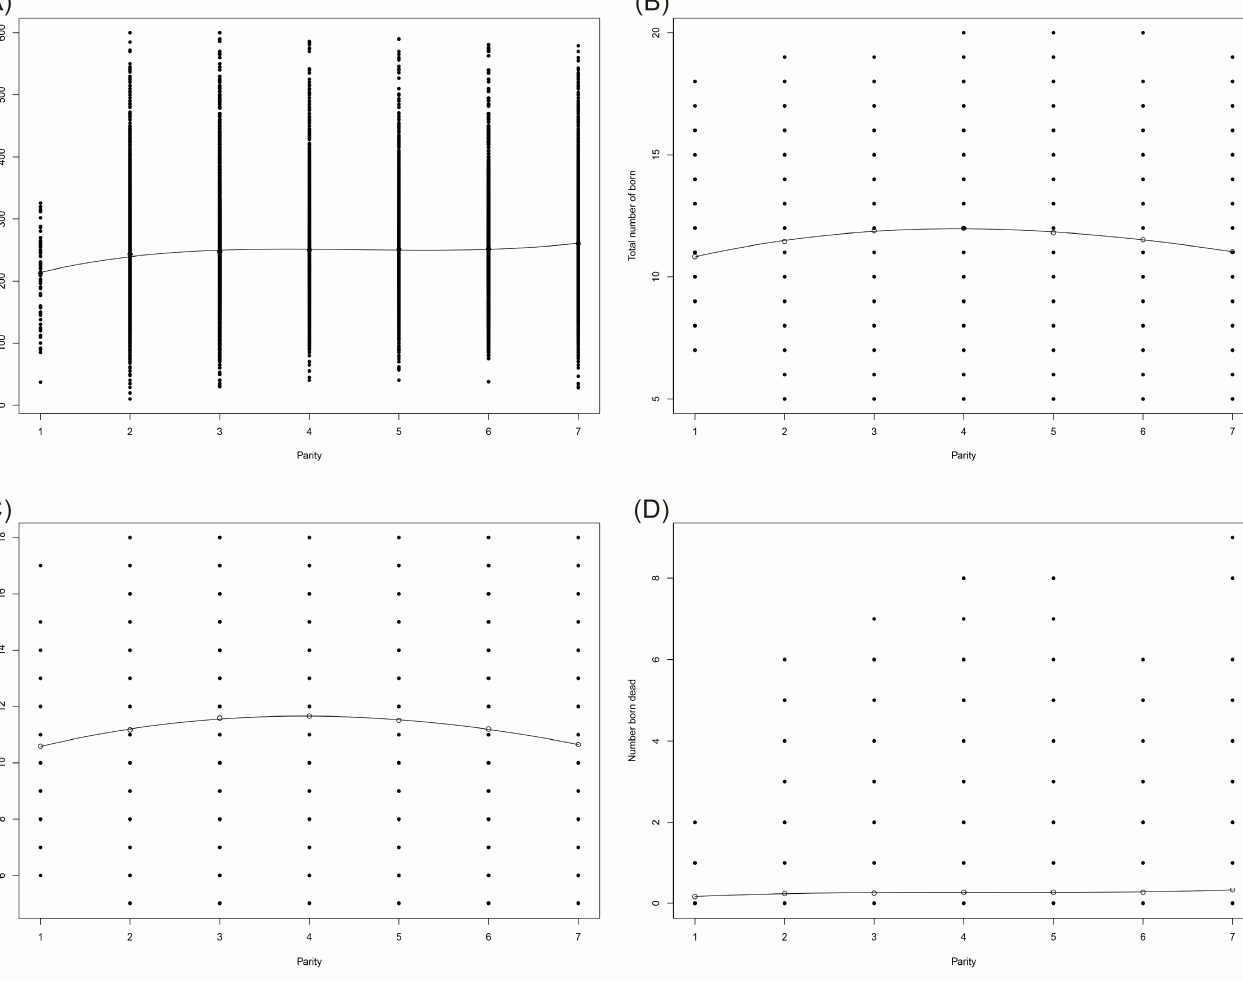
Figure 2. Cubic relation between parity and farrowing duration and litter size. Cubic relation between parity and farrowing duration ( A ), total number born ( B ), number born alive ( C ) and number born dead ( D